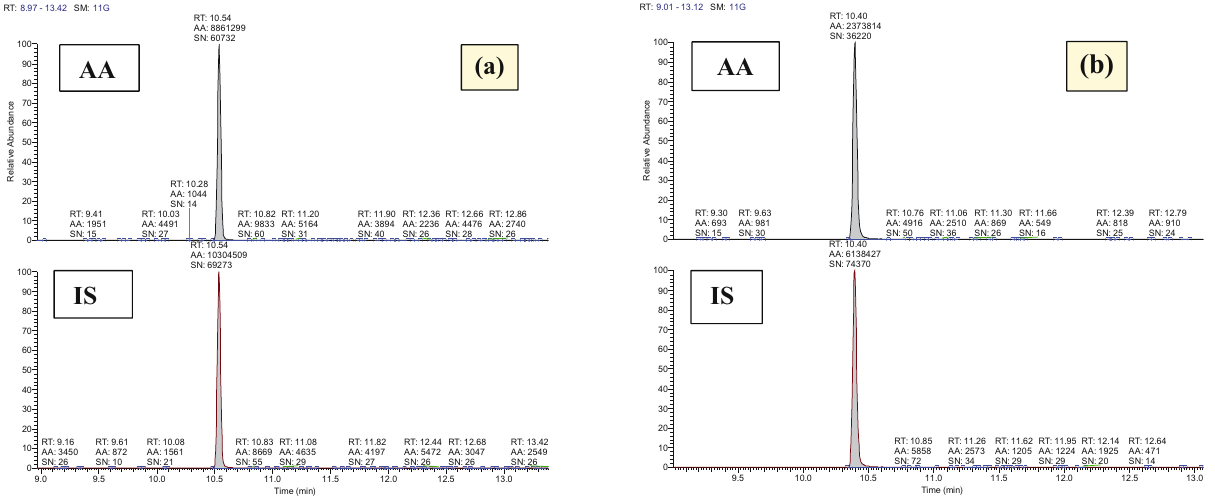
Figure 2: Chromatogram of chips ( a ) and French fries ( b ) samples obtained with the FC procedure. AA – acrylamide peak, IS – labeled AA peak.